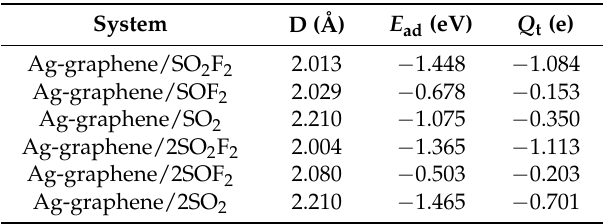
Table 2. Adsorption parameters of different systems. Reproduced with permission from [59]. Copyright 2016